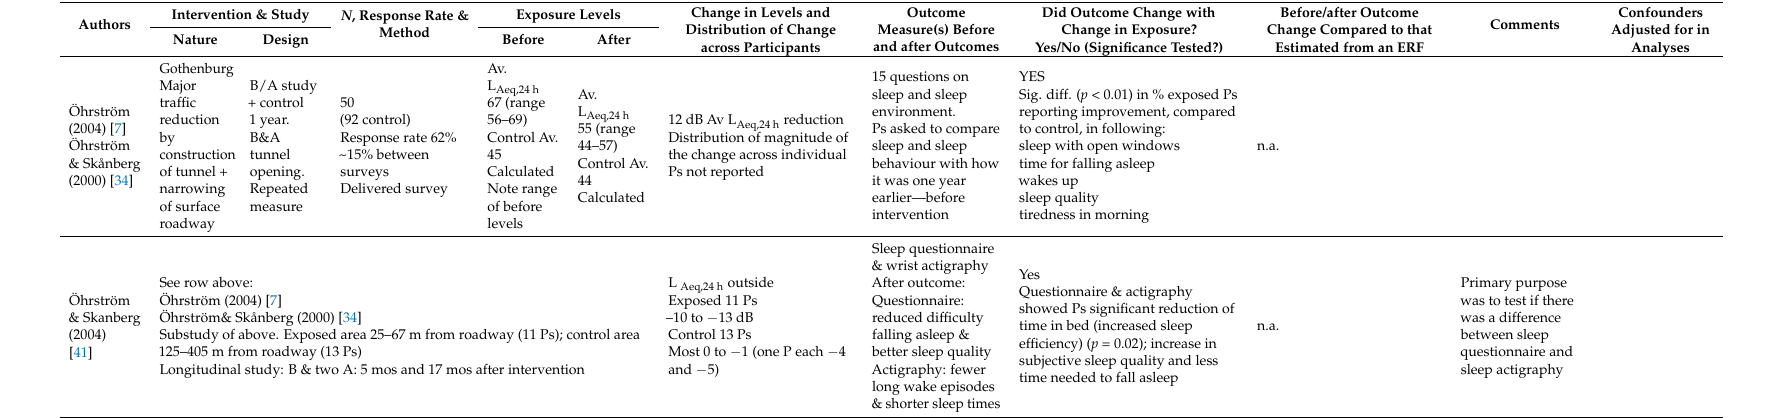
Table 9. New/Closed Infrastructure (Type